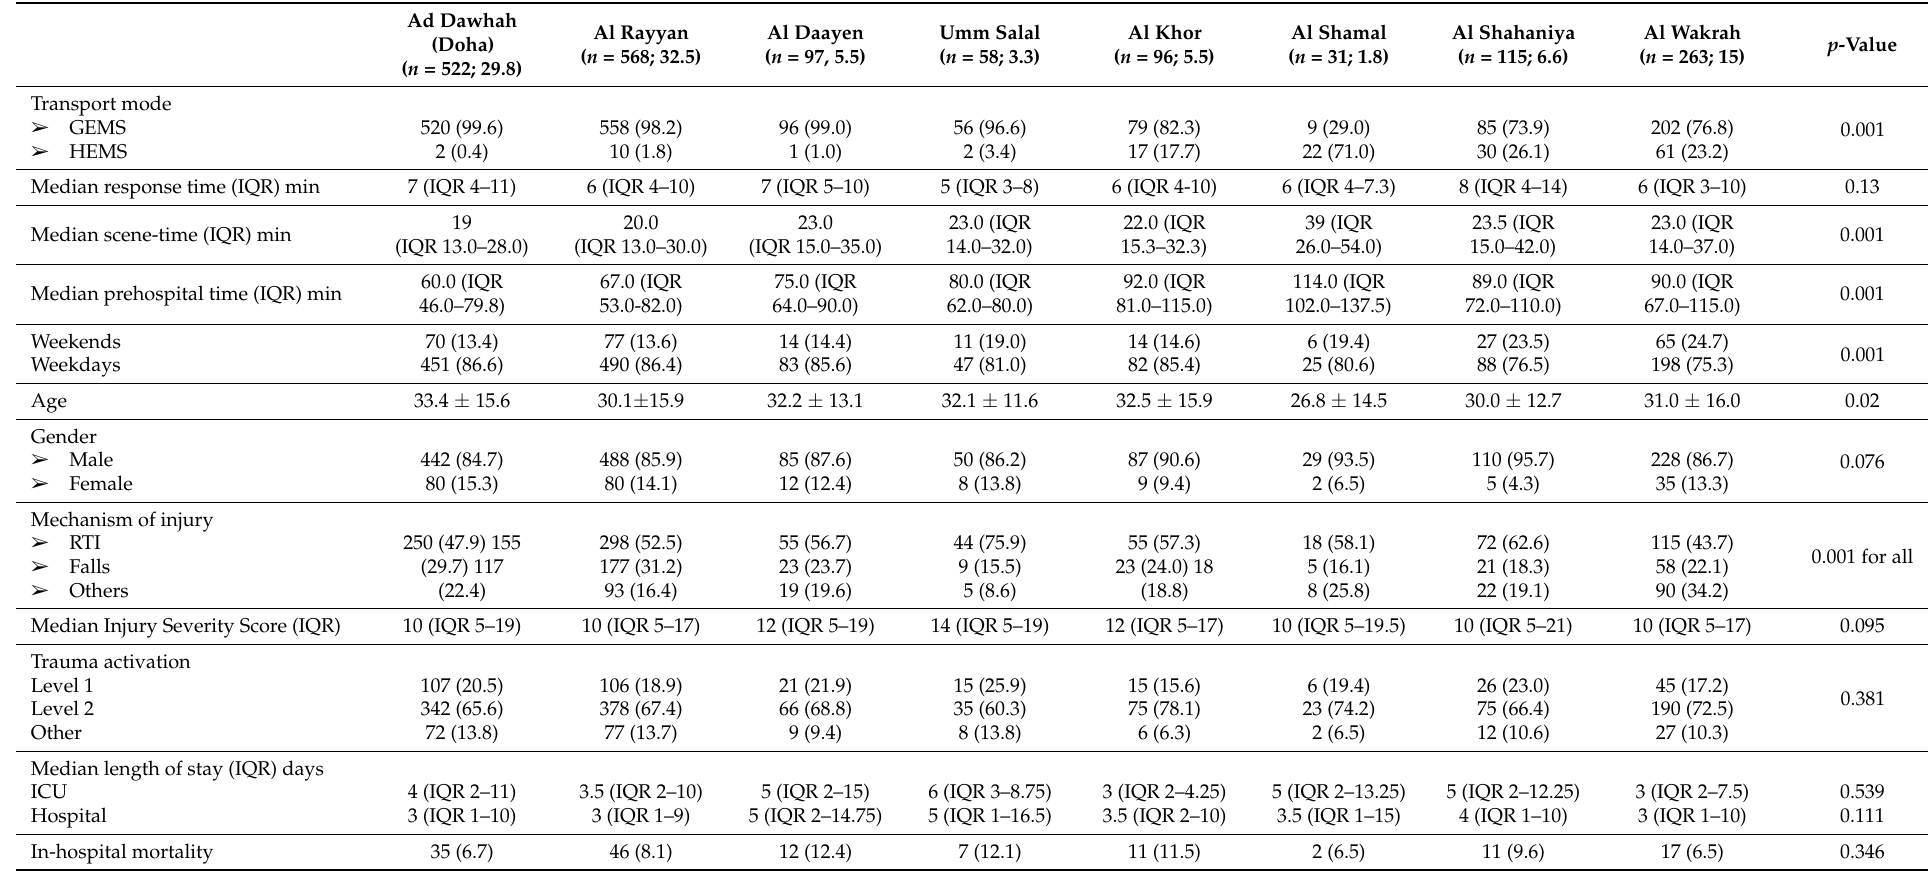
Table 3. Comparative analysis of prehospital and in-hospital data of trauma patients by municipalities in Qatar ( N = 1750)